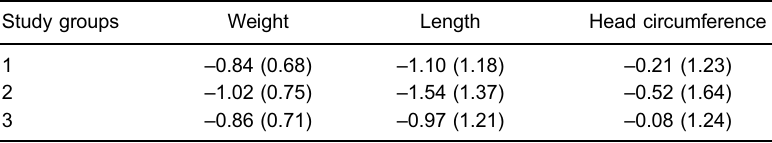
Table 2. Differences in Z-scores for weight, length, and head circumference between discharge and birth according to type of feeding at